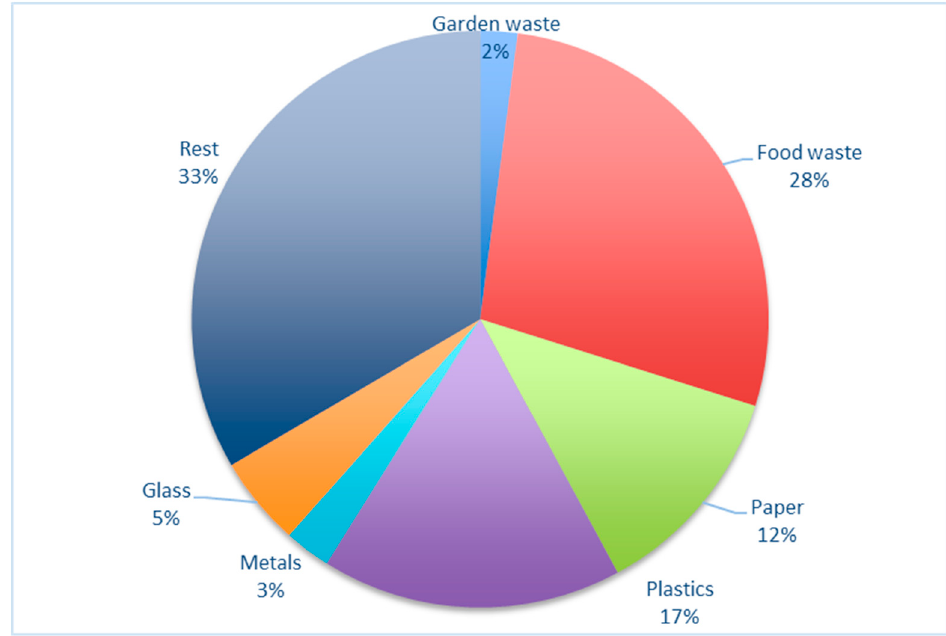
Figure 1. MSW waste composition in Mexico City 2017.